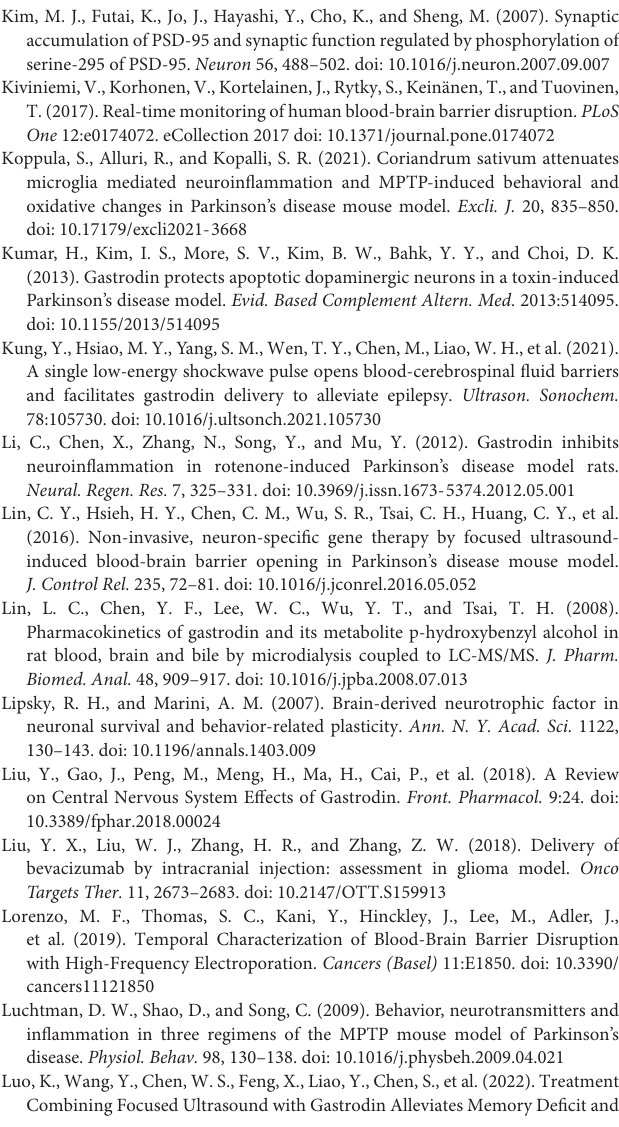
Supplementary Figure 1 | Behavioral changes of mice in each group at different time points. (A,B) The pole climbing time and grip time of mice in each group were compared at different time points after injection of 1-methyl-4-phenyl-1,2,3,6-tetrahydropyridine (MPTP). Compared to the Sham group. ∗ P < 0.05; ∗∗ P < 0.01; ∗∗∗ P < 0.001. One-way ANOVA with LSD test; n = 8, mean ±